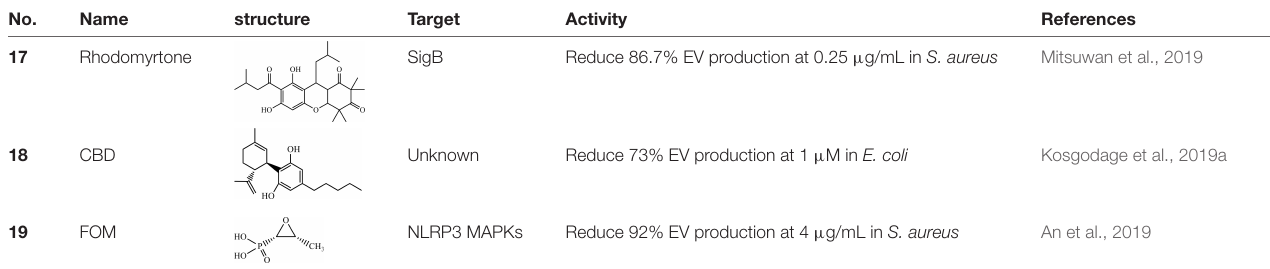
TABLE 3 | Other EV production inhibitors.